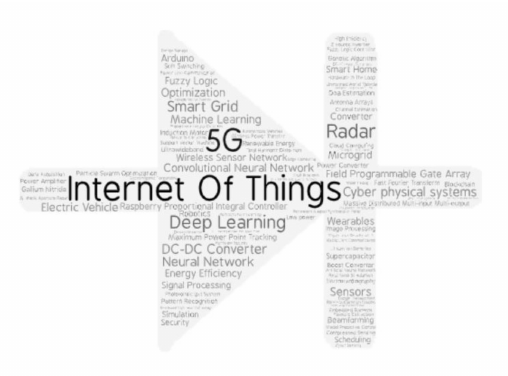
Figure 9. Representation of global keywords for all